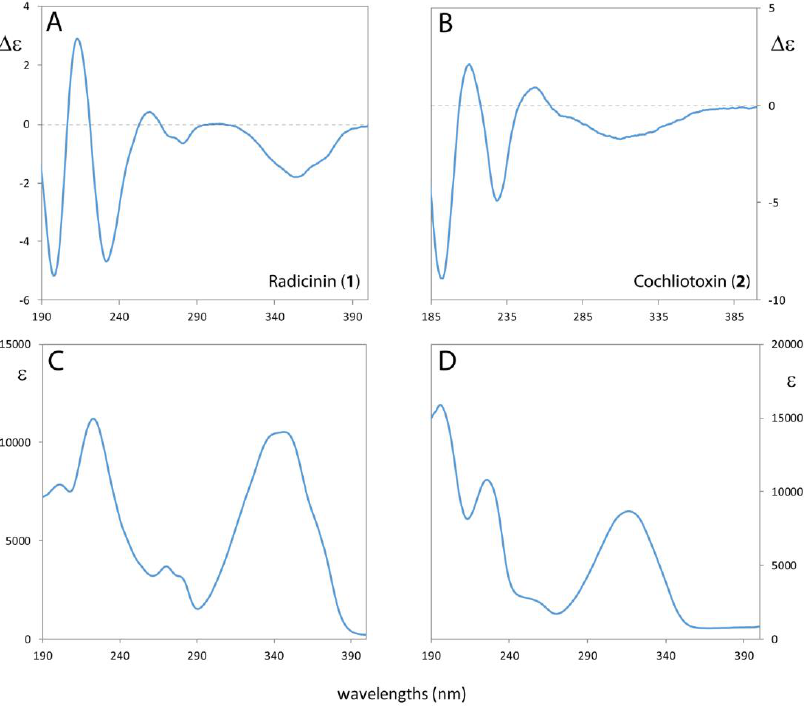
Figure 3. Experimental ECD and UV spectra of radicinin ( 1 ) (panels A , C ) and of cochliotoxin ( 2 ) (panels B , D ) in acetonitrile solution.